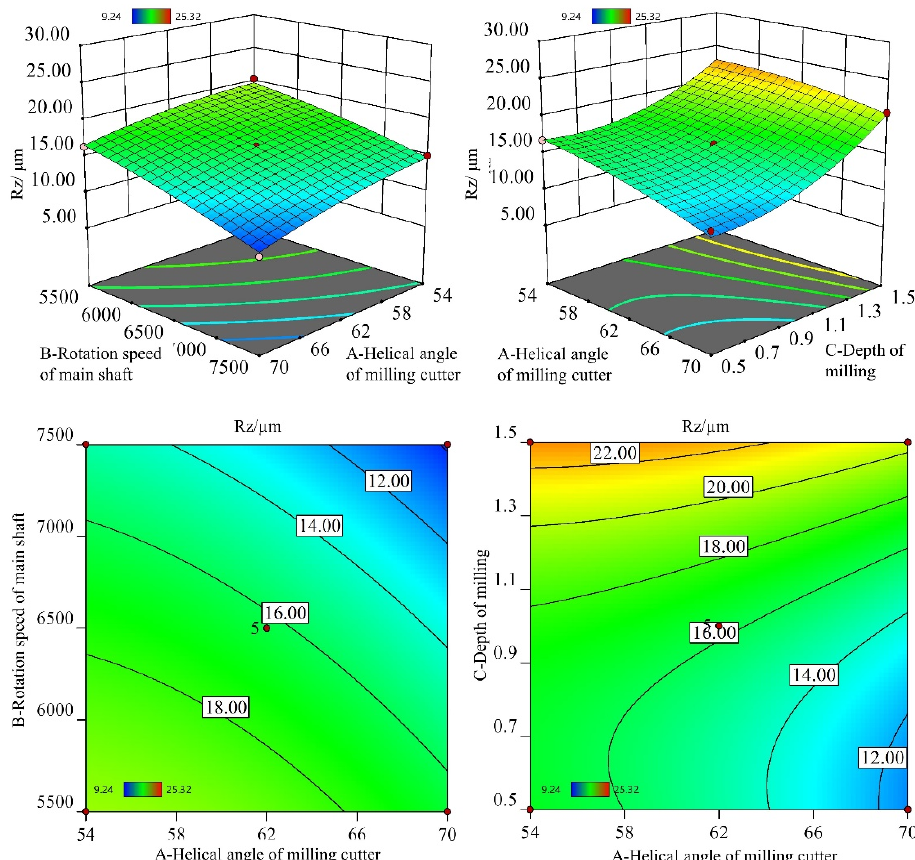
Figure 4. The 3D surface and contour graphs for Rz.